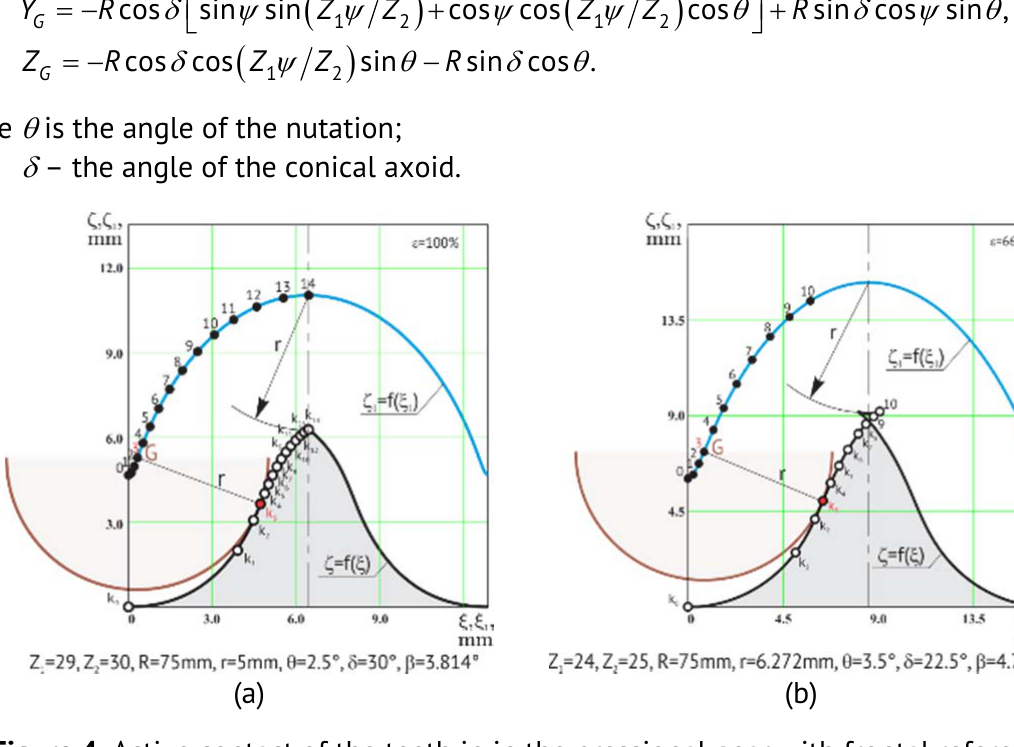
Figure 4 . Active contact of the teeth in in the pressional gear with frontal reference multiplicity  = 100% (a) and  = 66.6 %